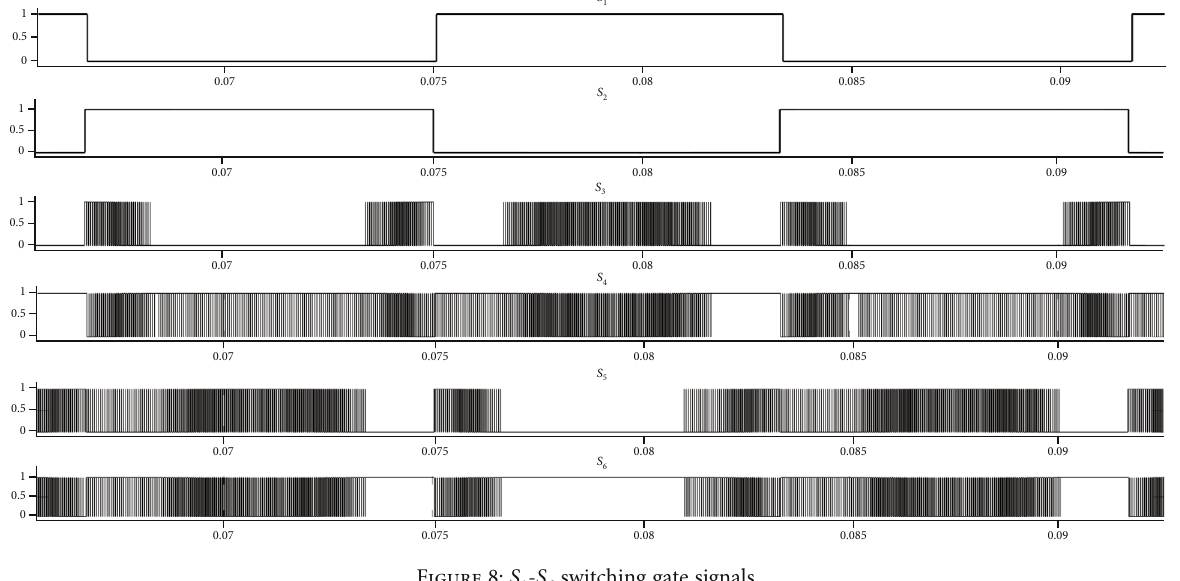
Figure 8: S - S switching gate 1 6